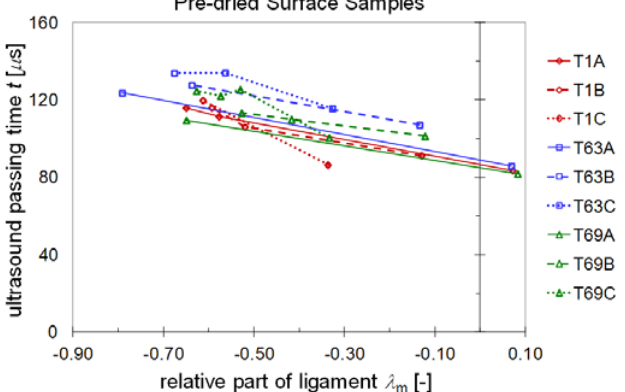
Figure 7: Relationship between the electrical resistivity difference,  , and the relative transverse distance between the effective crack tip and the measuring location,  m , for the wet surface samples evaluated at the notch (n) level.